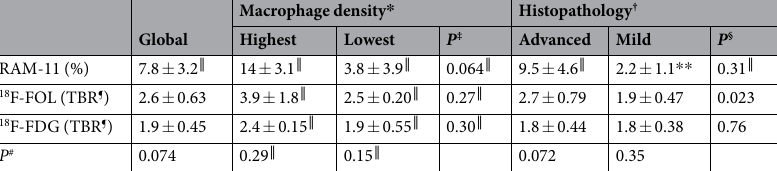
Table 3. Quantification of 18 F-FOL and 18 F-FDG PET/CT in rabbit aorta. Results are mean ± SD ( n = 4 rabbits, except ║ n = 3 and ** n = 2). All P values, paired t -test. * Based on anti-RAM-11 immunohistochemistry. † Based on hematoxylin-eosin staining. ‡ Highest vs . Lowest. § Advanced vs . Mild. ¶ Target-to-background ratio = SUV max, aorta / SUV mean. blood . #18 F-FOL vs . 18